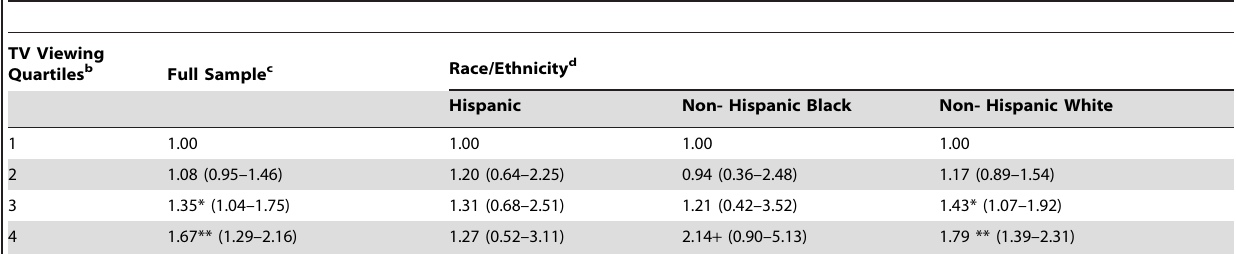
Table 2. Multivariate Ordered Logistic regression a for overweight/obesity according to TV viewing- Full sample and stratified by